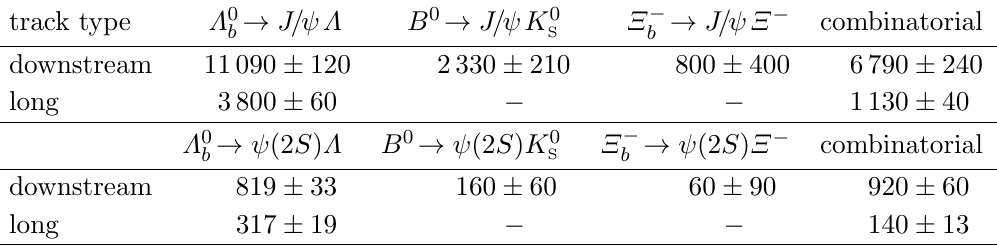
Table 1 . Yields from the invariant-mass (cid:12)ts in the range 5350 to 5750 MeV =c 2 of (top) (cid:3) 0 decays and (bottom) (cid:3) 0 ! (2 S ) (cid:3) decays for each component. b